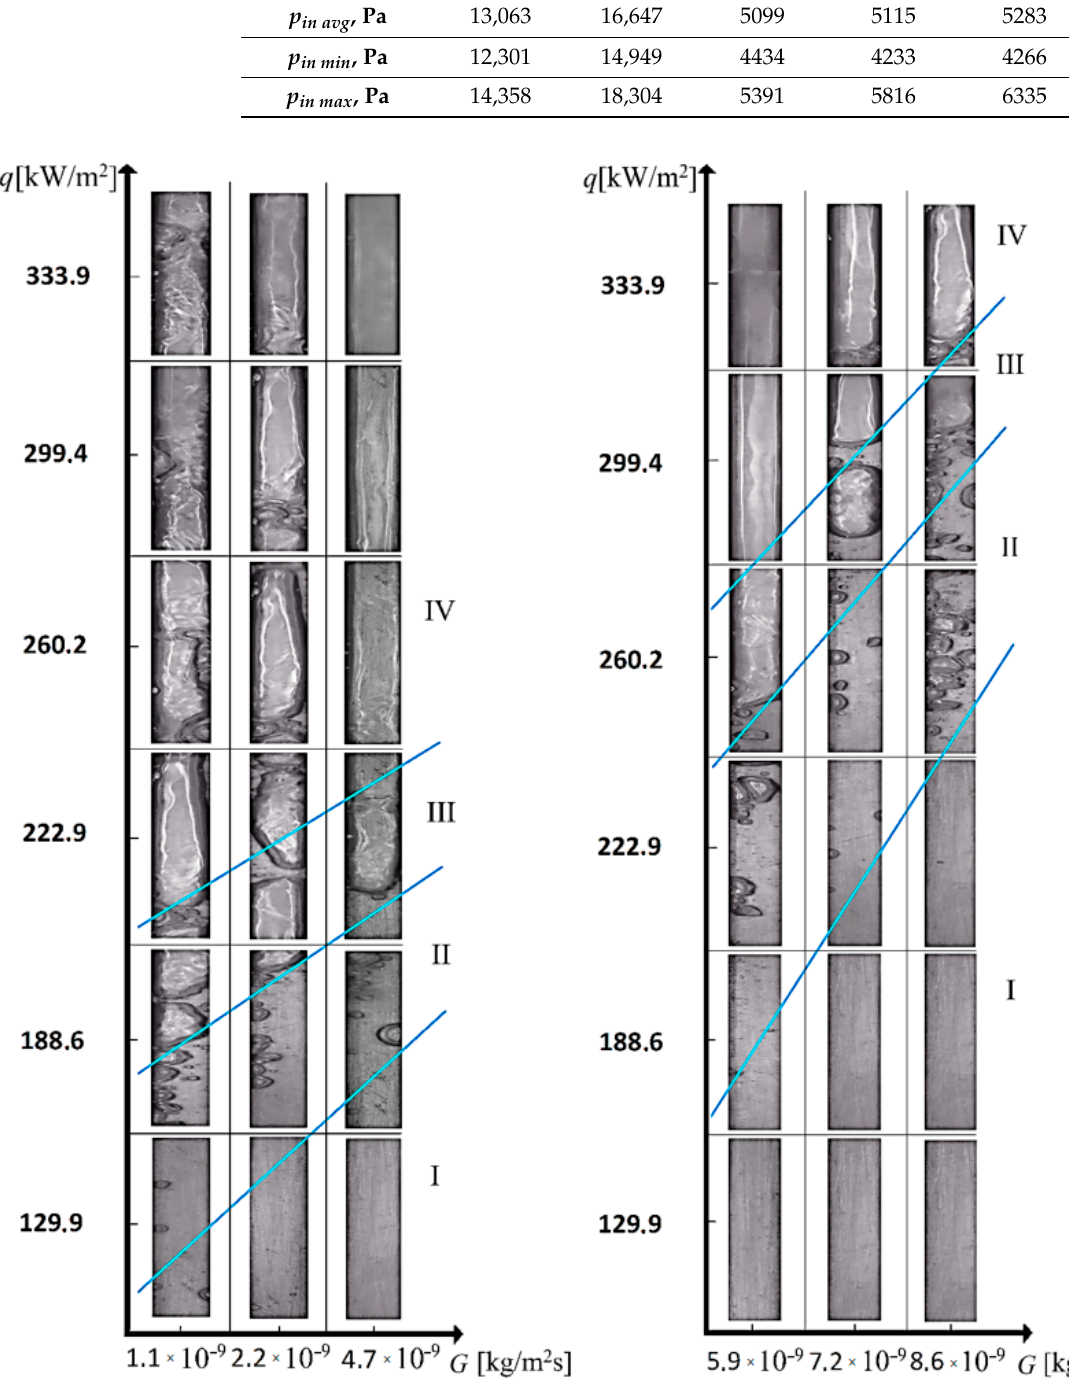
Figure 13. Sample maps of the observed two-phase flow structures as a function of heat flux and liquid volume flow based on data obtained in the experiment. I—single-phase liquid flow, II—saturated bubble boiling, III—cork flow, IV—film flow.